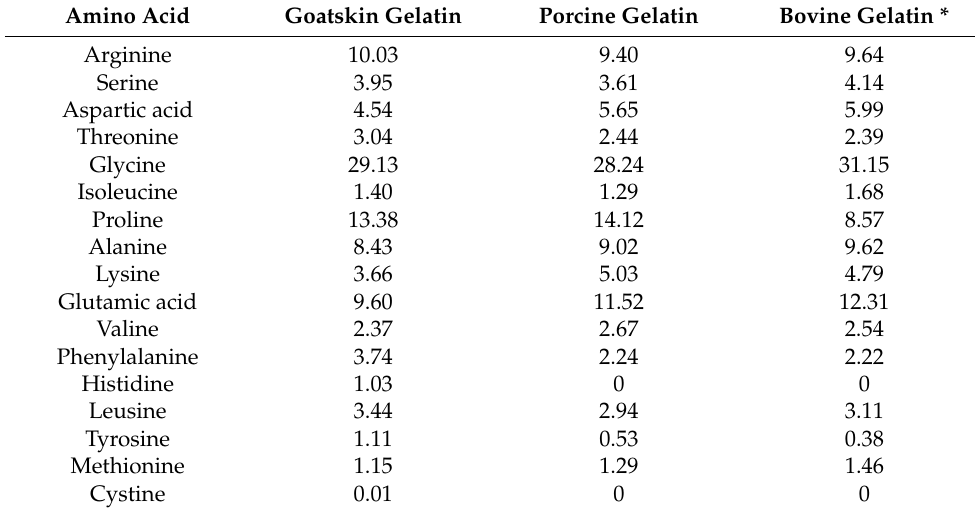
Table 1. Amino acid composition of goatskin gelatin, porcine gelatin, and bovine gelatin. Amino Acid Goatskin